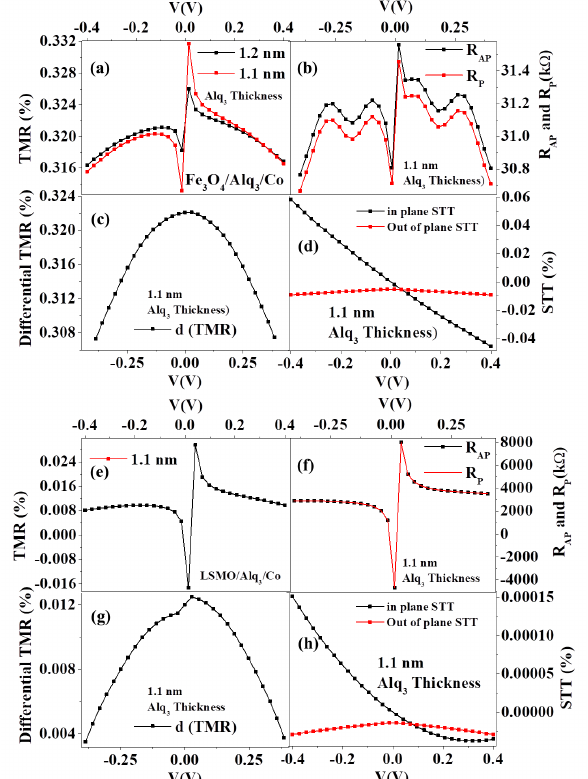
Figure 3. ( a ) Voltage-dependent Tunnel Magnetoresistance (TMR) for Fe 3 O 4 /Alq 3 /Co MTJ (mag- netic tunnel junction) device structure ( b ) Parallel and antiparallel resistances (R P and R AP ) versus voltage for MTJ structure ( c ) Differential TMR versus voltage for MTJ ( d ) Spin transfer torque (STT) versus voltage for the MTJ ( e ) Voltage-dependent Tunnel Magnetoresistance (TMR) for La 0.7 Sr 0.3 MnO 3 /Alq 3 /Co MTJ (magnetic tunnel junction) device structure ( f ) Parallel and antiparallel resistances (R P and R AP ) versus voltage for MTJ structure ( g ) Differential TMR versus voltage for MTJ ( h ) Spin transfer torque (STT) versus voltage for the